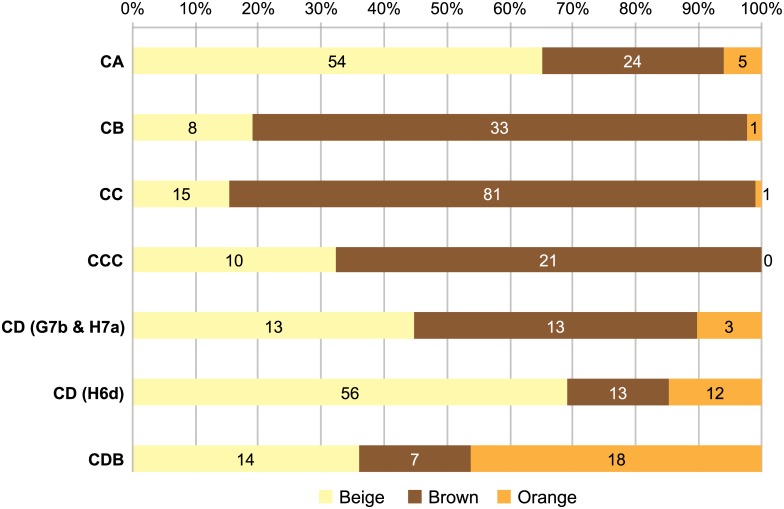
Proportions of major bone colour categories by layer.Burnt fragments are excluded and only the three most easily distinguishable colours are included (for example, bones recorded as “brown—orange” are excluded). Numbers show NSP values per category.